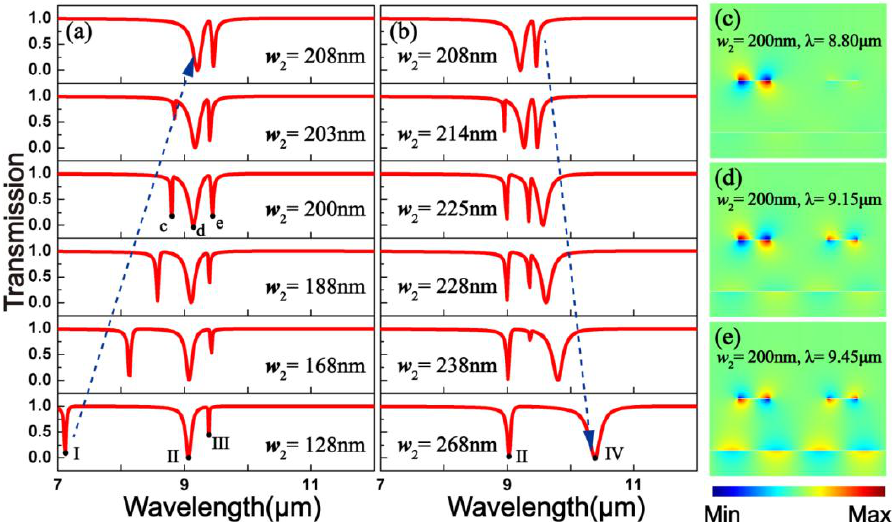
Figure 3. ( a , b ) Computerized ionospheric tomography transmission spectra at different widths w 2 . Here, p = 1200 nm, w 1 = 208 nm, g = 350 nm, and E F = 0.6 eV; ( c – e ) Field distributions E y of the transmission dips.